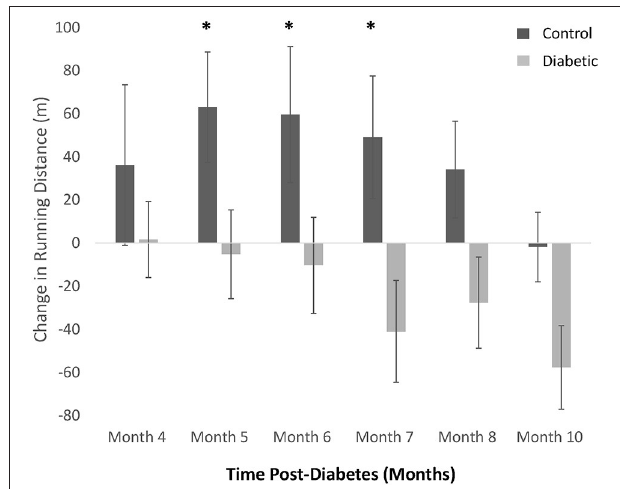
FIGURE 4 | Treadmill exercise tolerance testing. The difference in distance run relative to Month 3 in individual rats is averaged within each cohort (control vs. diabetic). A significant difference between control and diabetic rats is observed at Months 5, 6, and 7. Significance at individual timepoints is indicated (* p < 0.05). Data represented as mean ±